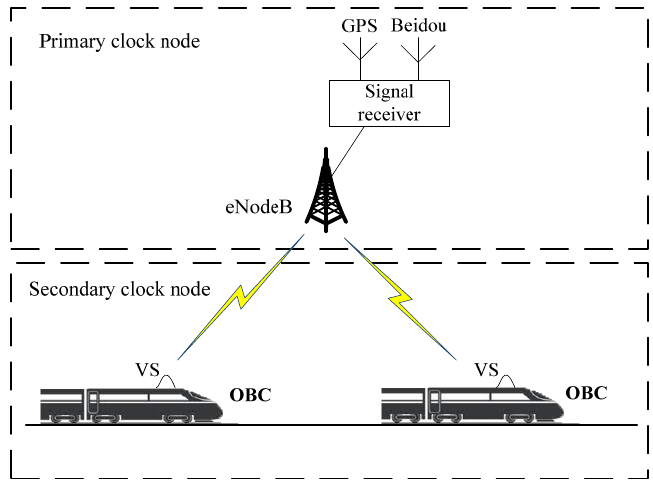
Figure 3. The time synchronization process of LTE-R train-to-ground communication. In Figure 3, eNodeB is set as the primary clock node to obtain accurate time information by using GPS or Beidou satellite signals as the external clock source. The OBC is set as the secondary clock node. The master–slave clock establishes two-way communication through the all-IP network of the LTE-R wireless channel, and it transmits a PTP time synchronization message to achieve time synchronization between the eNodeB and OBC train-to-ground